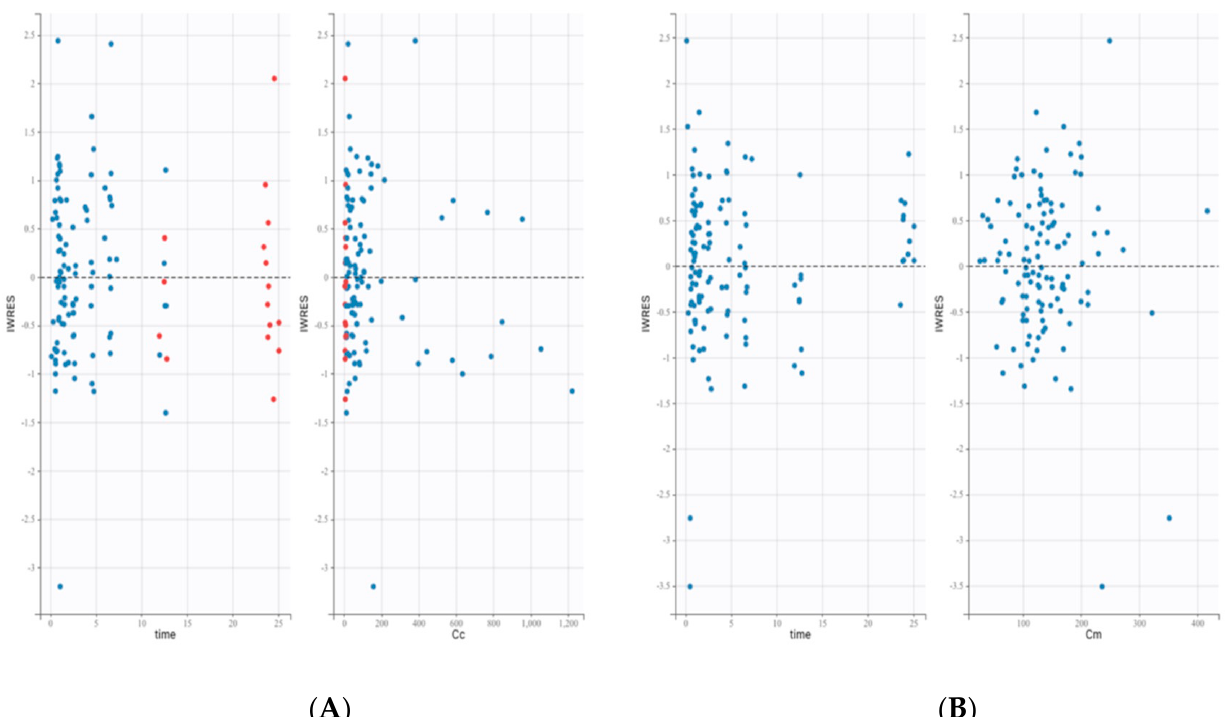
Figure 3. ( A ): daunorubicin residual scatterplots. ( B ): daunorubicinol residual scatterplots. These plots display the individual weighted residuals (IWRES) as scatter plots with respect to the time and the concentration. Red dots are censored data.